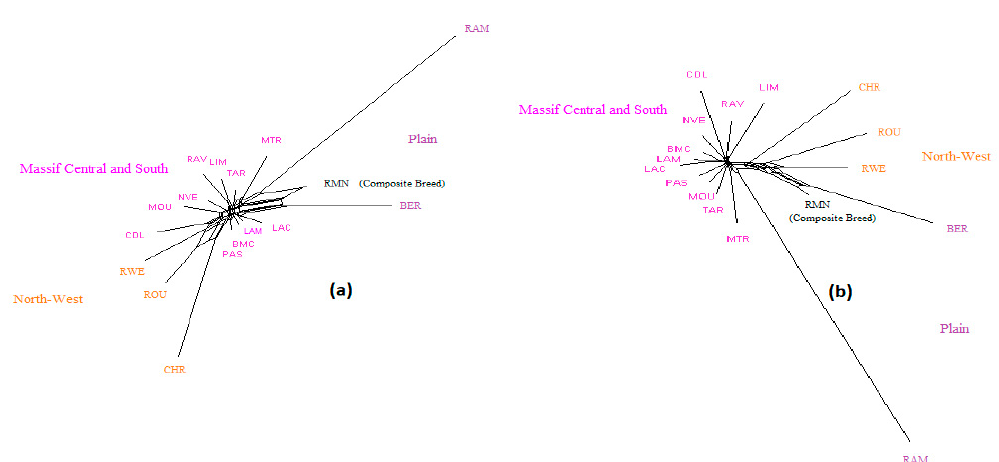
Figure 3. NeighborNet graph considering French sheep breeds, from a matrix of Reynolds’ distances. ( a ) Plot obtained from the microsatellite dataset; ( b ) plot obtained from the SNP dataset. Information concerning the region of origin of each breed was extracted from [21]; for breed names see codes in